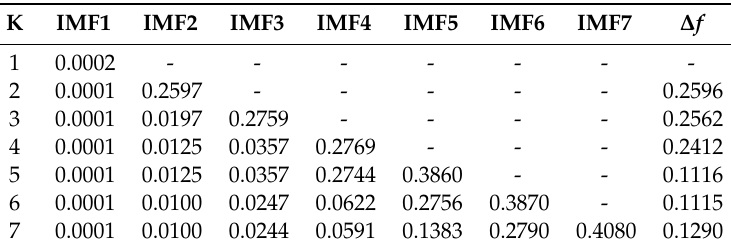
Table 2. Center frequency corresponding to di ff erent mode number, k .